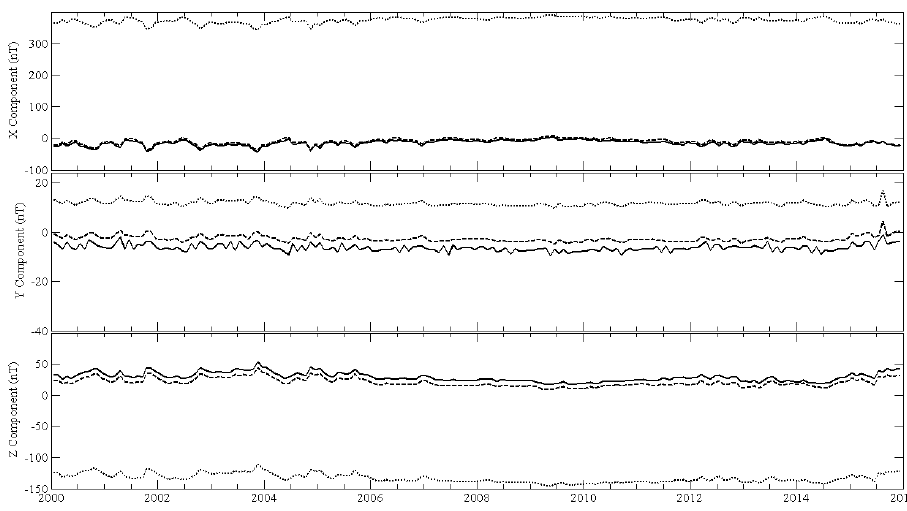
Figure 3. Differences between monthly mean values observed at FUR observatory and respective values predicted by EMM2015 model (dashed line), POMME-9 model (solid line) and CM5 model (dotted line).